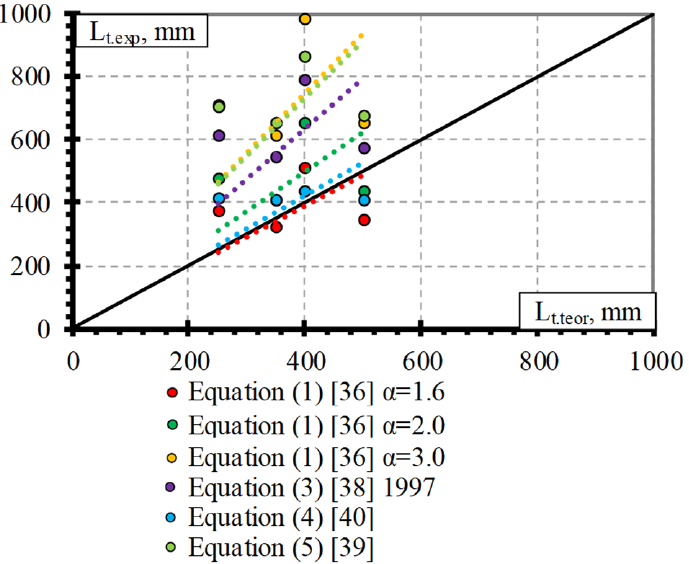
Figure 10. Comparison of experimental and theoretical transfer length results of the BFRP bars. Statistical analysis was additionally performed to verify the proposed values of the bond shape factor α . The statistical results for the CFCC strands (Table A5), CFRP bars (Ta- ble A6), AFRP Arapree bars (Table A7), AFRP Fibra and Technora bars (Table A8), all AFRP bars (Table A9), and BFRP bars (Table A10) are presented in Appendix B. The analyzed re- sults are M, STD and COV—mean value, standard deviation, and coefficient of variation of L t.teor /L t.exp , respectively, N total —total number of specimens, OV and UV—overestimated and underestimated values of L t.teor /L t.exp , respectively. The comparison of the bond shape factor α and a number of experimental points overestimating (OV = L t.teor /L t.exp ≥ 1)